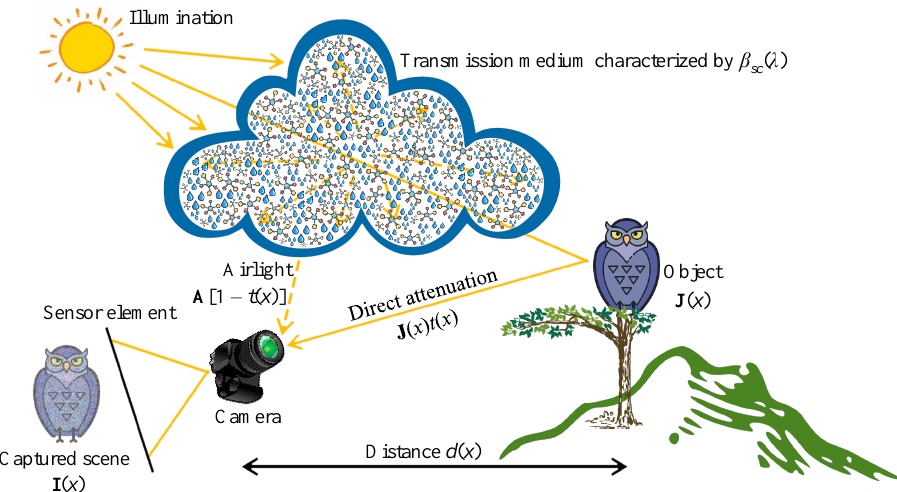
Figure 3. Visual illustration of the optical image formation in the